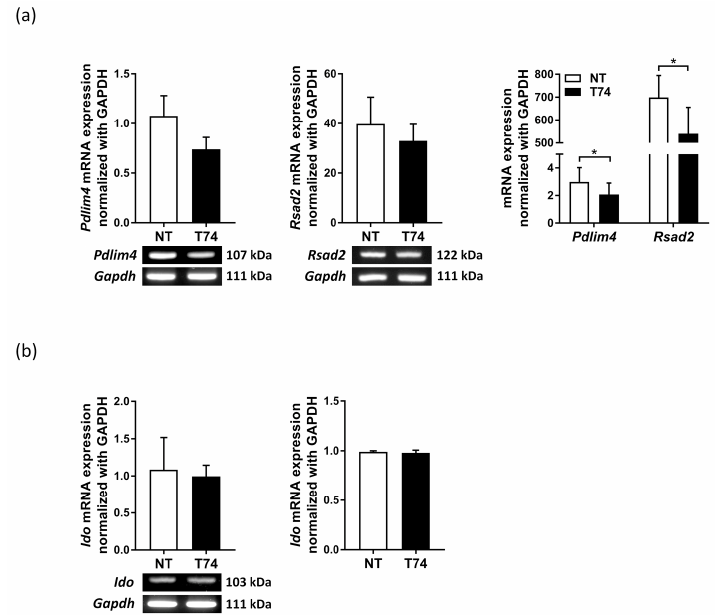
Figure 3. mDC markers Pdlim4 and Rsad2 were downregulated in T74-DCs. ( a ) Detection of Pdlim4 , Rsad2 , and ( b ) Ido1 mRNA by RT-PCR (left) and qRT-PCR (right). Values in panels were normalized to Gapdh expression, n = 3. Data are representative of three independent DC preparations and are expressed as the mean ± SEM. * p < 0.05.